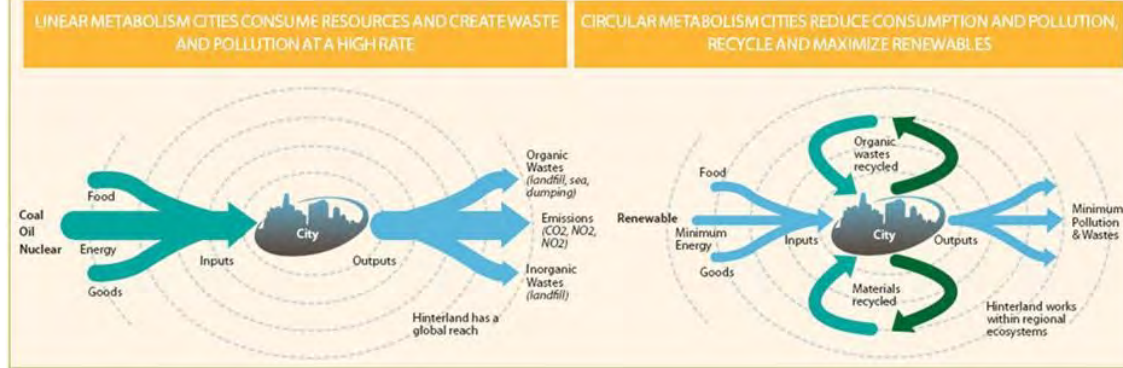
Figure 3. Linear versus circular urban metabolism (Girardet,